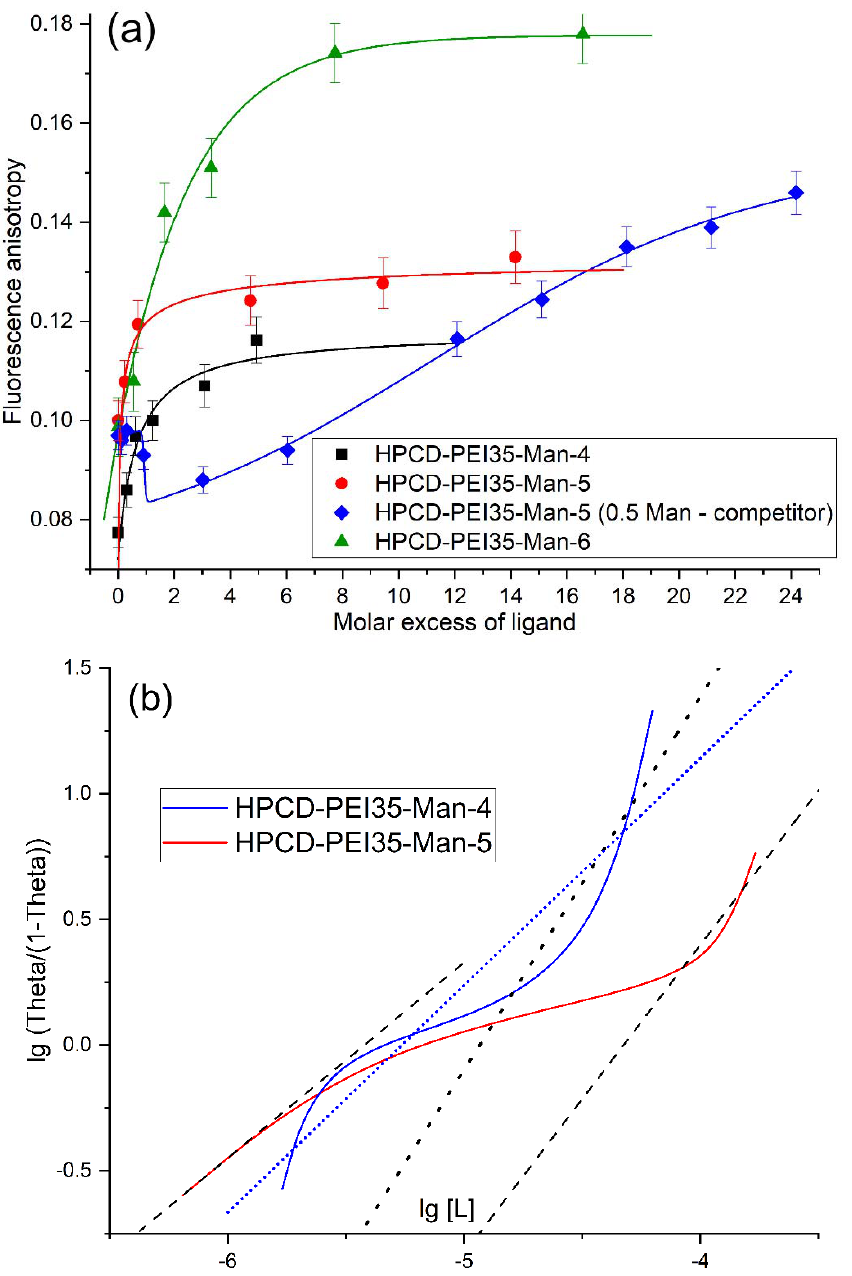
Figure 3. ( a ) Tryptophan fluorescence anisotropy plot: titration of ConA by ligands HPCD-PEI35- Man group. Fitted with Hill (3), Boltzmann (4) and BiDoseResp equations from Origin. ( b ) Hill’s linearization plot of fluorescence anisotropy. [L]—the equilibrium concentration of the ligand. Theta-proportion of bound receptor. Two dash lines (– –) for red curve are a linearized model of two types of binding. Two dot lines (```) for blue curve are a linearized model of the most affinity binding and average observed binding (short dots). C 0 (dimeric ConA) = 38 μ M. Ligand concentration varied from 1 to 250 μ M. In the case of competitor binding (Figure S12), we used mannose with [Man] = 0.5 M. Natrium-citric buffer solution (0.04 M, pH 5.5). C(Ca 2+ ) = C(Mn 2+ ) = 1 mM. T = 22 °C. The interaction of “light” conjugates (spermine group with molecular weight in range from 6 to 9 kDa) with ConA was studied by changing the fluorescence intensity F of the aromatic tryptophan residues (the fluorescence of tyrosine residues under these conditions is significantly less: λ max (Tyr) = 303 nm, λ max (Trp) = 340 nm, λ max (observed) = 335 nm) in ConA (Figure S13 for mannan). The analysis was carried out similarly to the